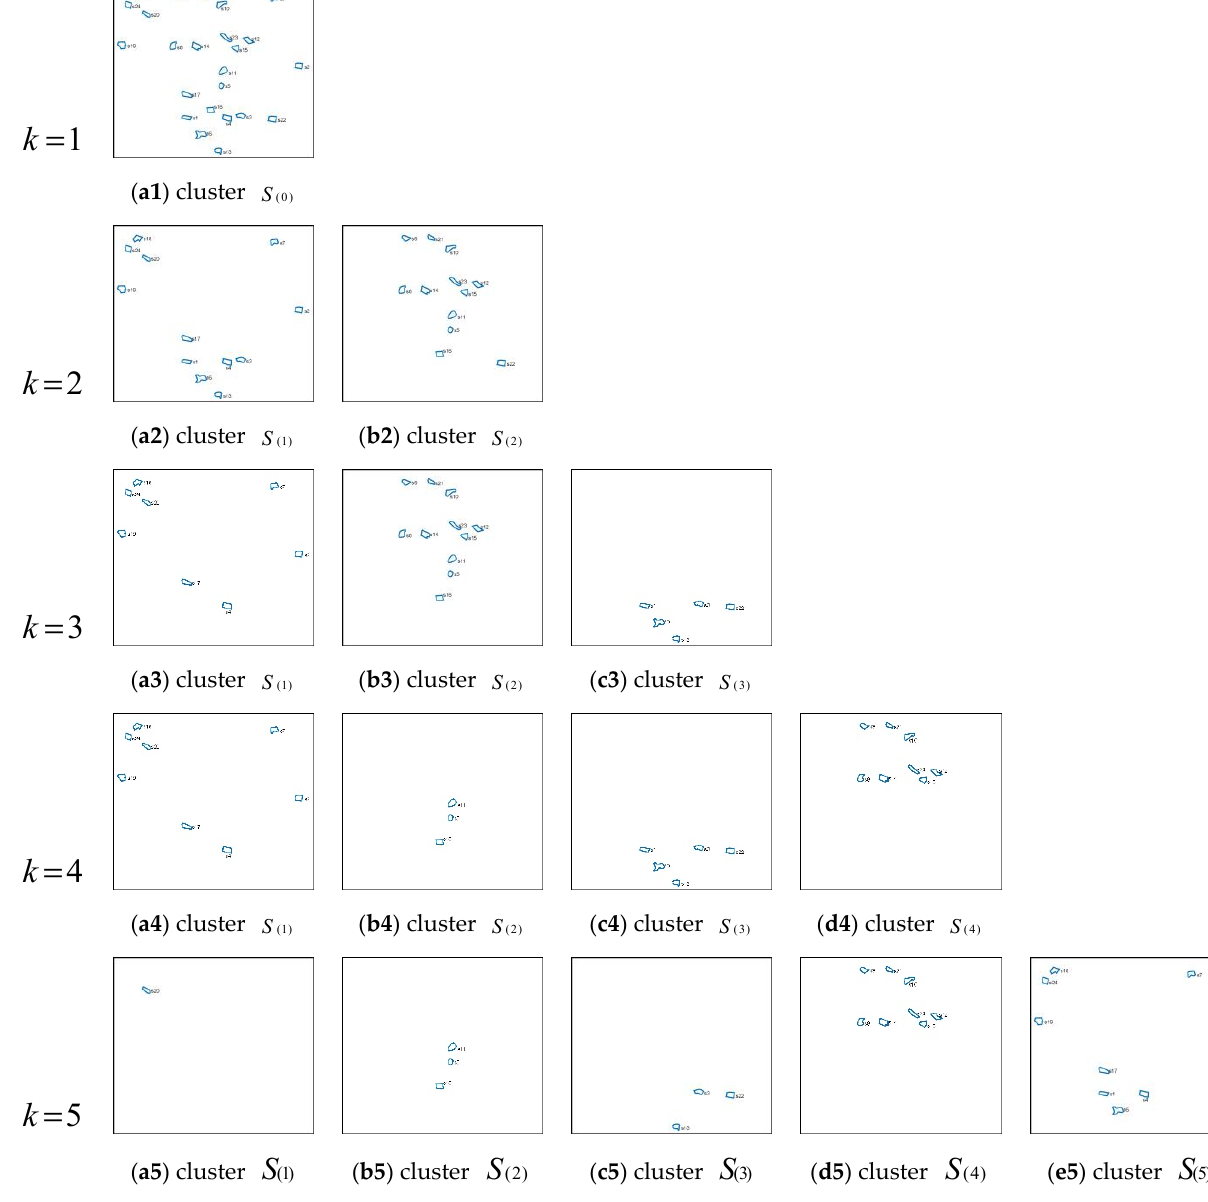
Figure 5. The visualization results of clusters under different cluster quantity conditions. ( a1 ) shows the initial cluster S (0) . ( a2 ~ b2 ) show the clusters S (1) and S (2) when the number of clusters is k = 2. ( a3 ~ c3 ) show the clusters S (1) ~ S (3) when the number of clusters is k = 3. ( a4 ~ d4 ) show the clusters S (1) ~ S (4) when the number of clusters is k = 4. ( a5 ~ e5 ) show the clusters S (1) ~ S (5) when the number of clusters is k = .